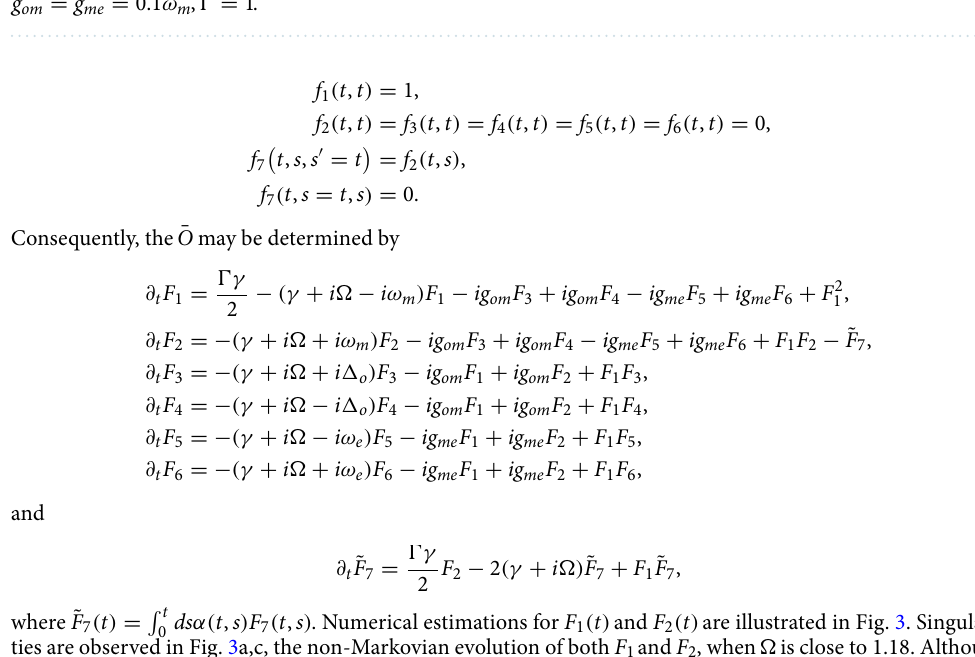
Figure 3. Evolution of the real and imaginary value of the complex coefficient function F 1 ( t ) . In ( a , c ), γ = 0.5 , non-Markovian regime. In ( b , d ), γ = 5.0 , Markovian regime. Parameters are chosen as: ω o = ω e = ω m , g om = g me = 0.1 ω m , Ŵ = 1